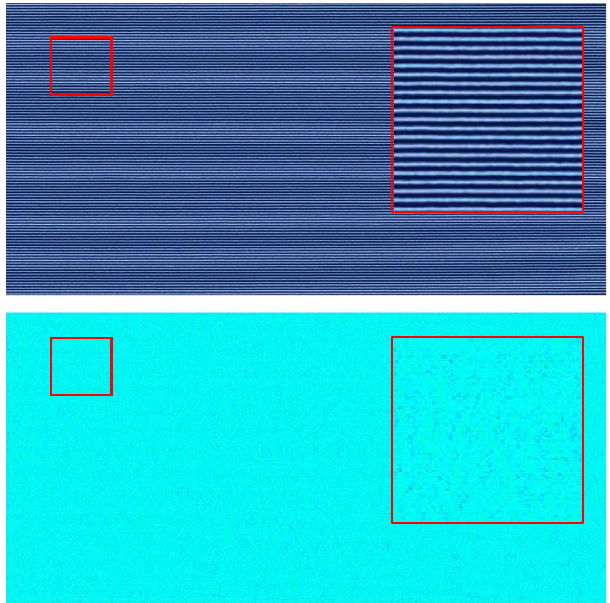
Figure 3. Snapshots of horizontally aligned lamellae obtained with a zone velocity of v zone = 0.0233 and a zone width of w zone = 80 ˜ l without templating. The inhomogeneous mobility field moves from left to right across the domain – this image corresponds to the end of the simulation when the zone has moved across the entire sample. This sample contains no topological